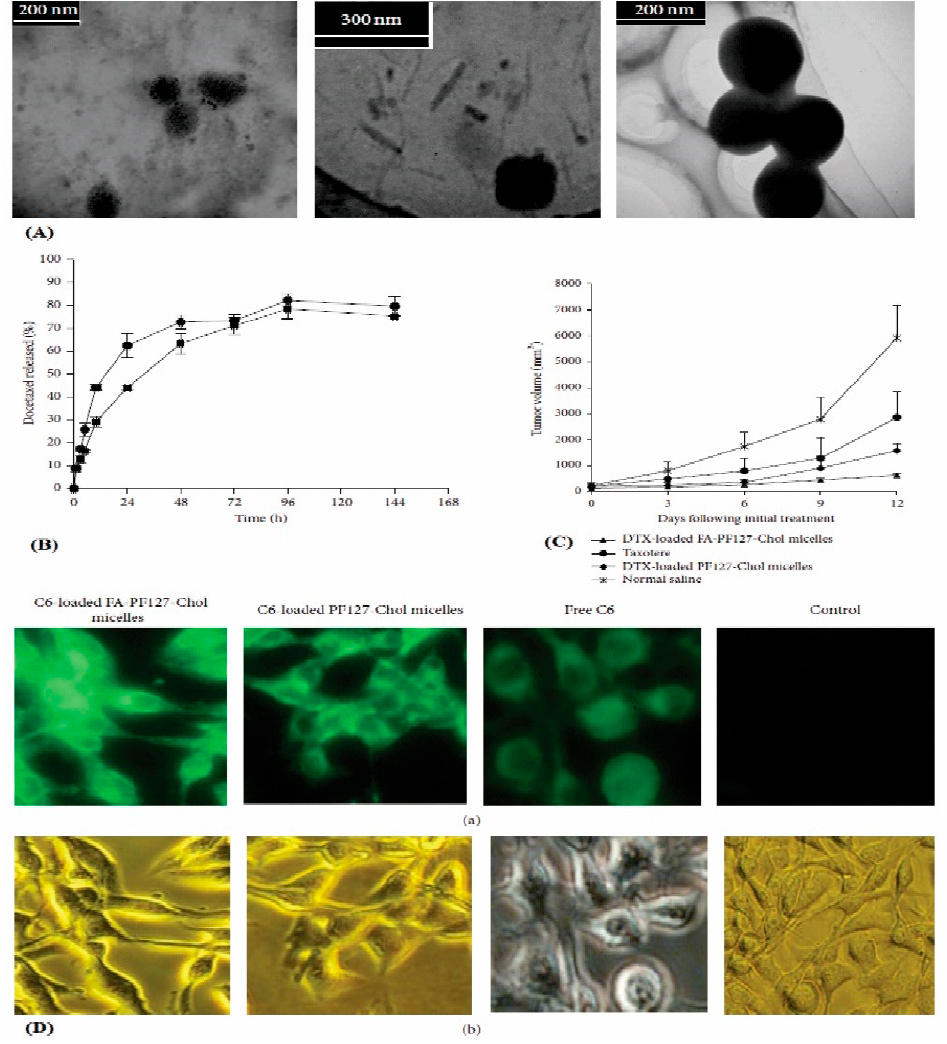
Figure 2. Illustration of ( A ) TEM analysis; ( B ) in vitro drug release studies; ( C ) in vivo antitumor efficacy studies on B16F10 melanoma bearing mice; ( D ) Results of in vitro cellular uptake studies of C6 loaded FA-targeted PF127 Chol micelles, C6 loaded non-targeted PF127 Chol micelles, free C6, and culture media (Control) via (a) fluorescent microscopy and (b) visible light microscopy.